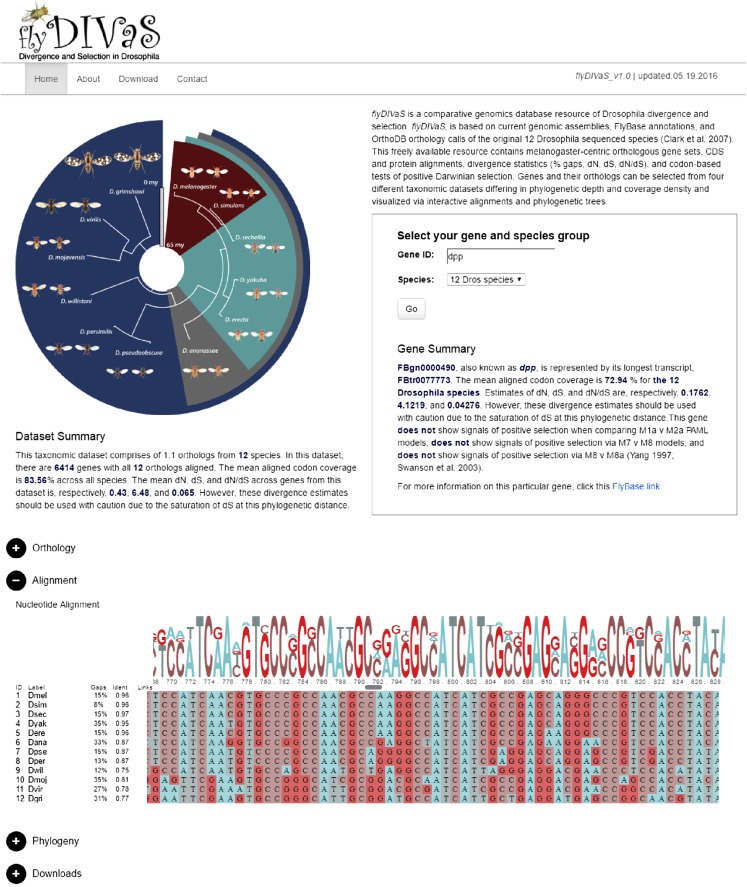
flyDIVaS homepage. Search tool allows users to select a Drosophila gene and one of four taxonomic datasets potentially available. Once these parameters are chosen, a summary of the gene and its associated alignment, divergence, orthology, and selection test results are automatically generated. Phylogenetic view changes when a taxonomic dataset is chosen. A summary of orthology, alignment, and divergence is also provided for the chosen dataset. An interactive JavaScript plugin is provided for users to explore alignment characteristics of their selected gene. Features not shown in figure include a gene-specific neighbor-joining tree (Saitou and Nei 1987) of the aligned sequences, and downloadable fasta files. flyDIVaS can be accessed at www.flydivas.info.